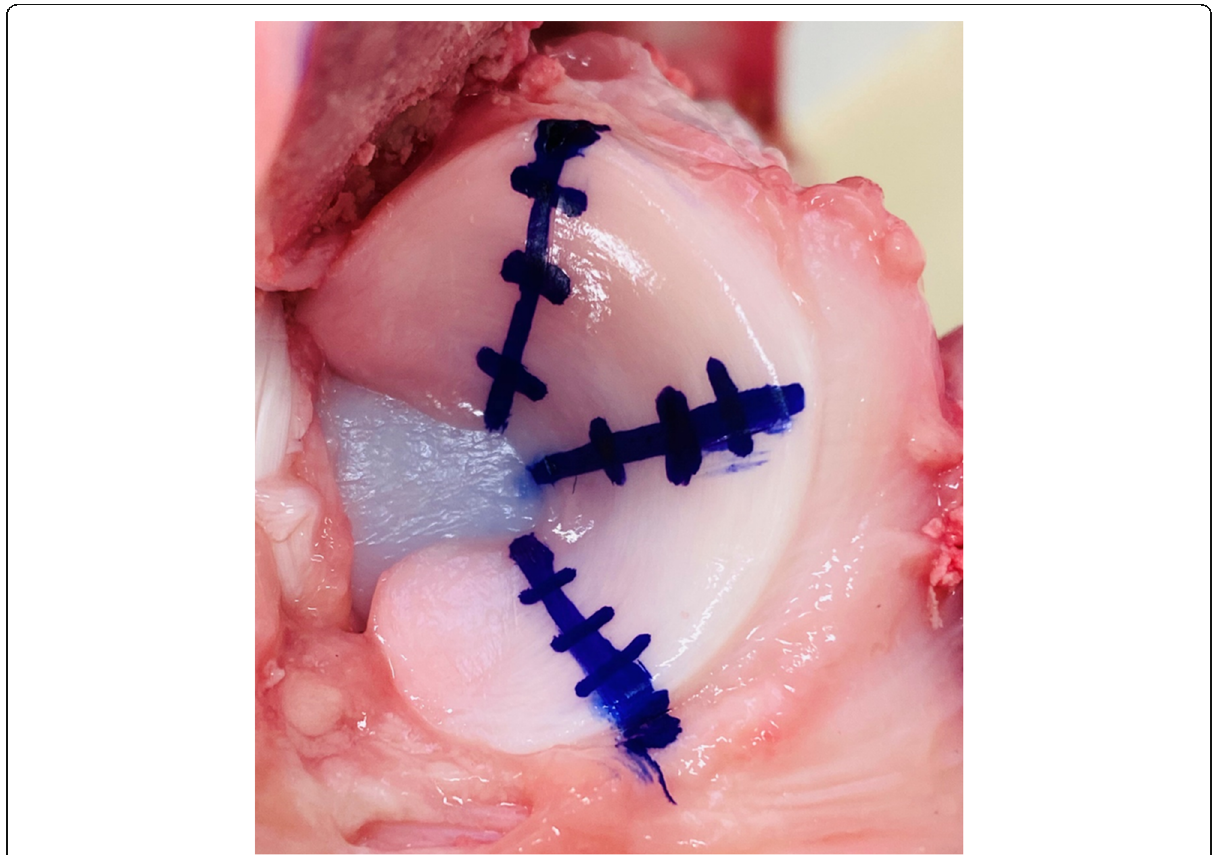
Fig. 3 Phased inner resections of the medial meniscus. The inner portion of the meniscus was serially resected (30%/60%/90% width) along a crescent shape of the medial meniscus. Three points (30%, 60% and 90% of width) was marked based on the measurement of total width of meniscus at three segments (anterior, middle and posterior). The anterior and posterior roots were left